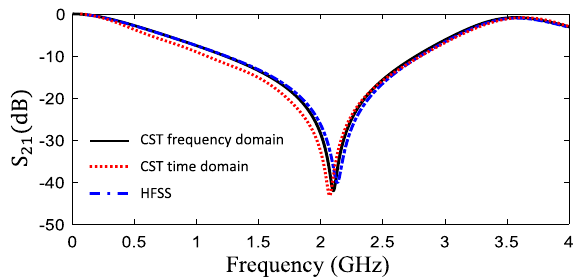
Figure 5. Transmission coefficient amplitude of the designed FSS.